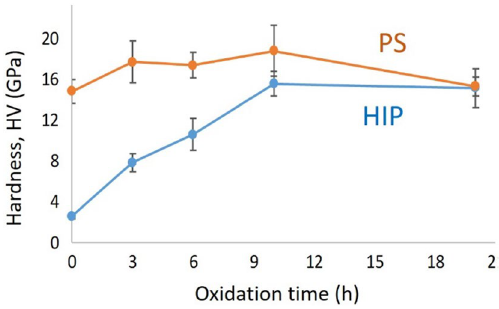
Figure 10. Hardness of HIP and PS sintered Al 2 O 3 versus oxidation time of AlN base